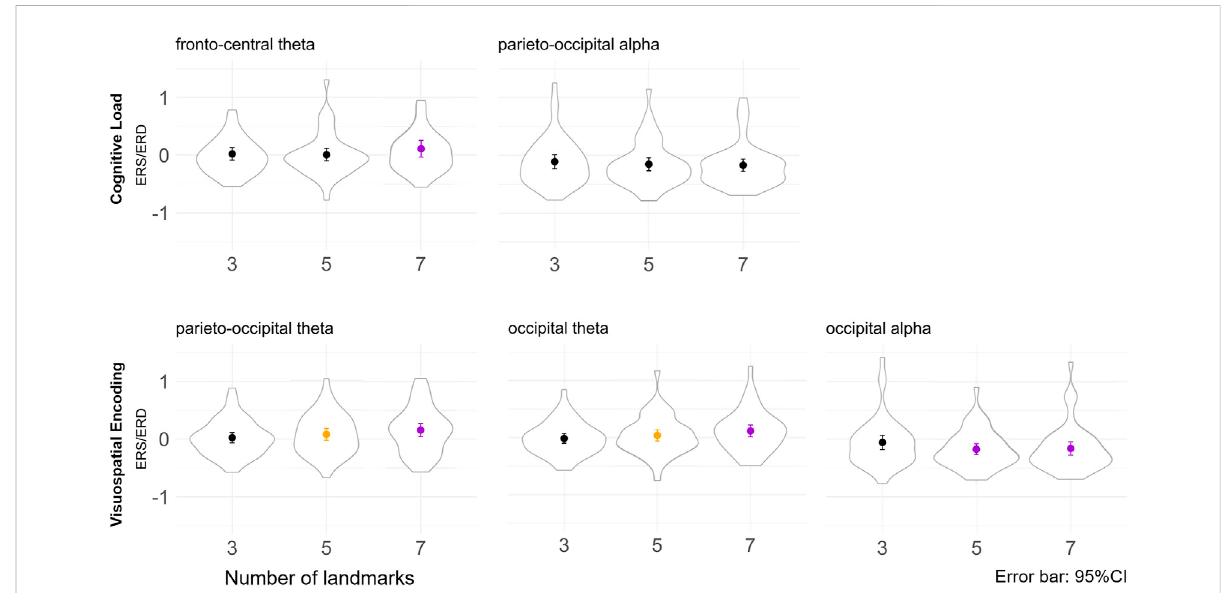
FIGURE 6 Mean ERD/ERS values of the map-event window (i.e., 0 – 5 s) for mean frontal-central theta ERS and mean parieto-occipital alpha ERD indicating cognitive load changes (top panel), and mean parieto-occipital theta ERS, occipital theta ERS and occipital alpha ERD indicating visuospatial encoding (bottom panel). Error bars indicate ±1.96 standard error (i.e., 95% CI) of the mean. Means in the 3-landmark condition are depicted in black, serving as a baseline in each violin plot. Signi fi cant differences between means at p < 0.05 are shown with different colors within the same violin plot. Means presented in the same color within the same violin plot indicate no signi fi cant difference between the means at p ≥